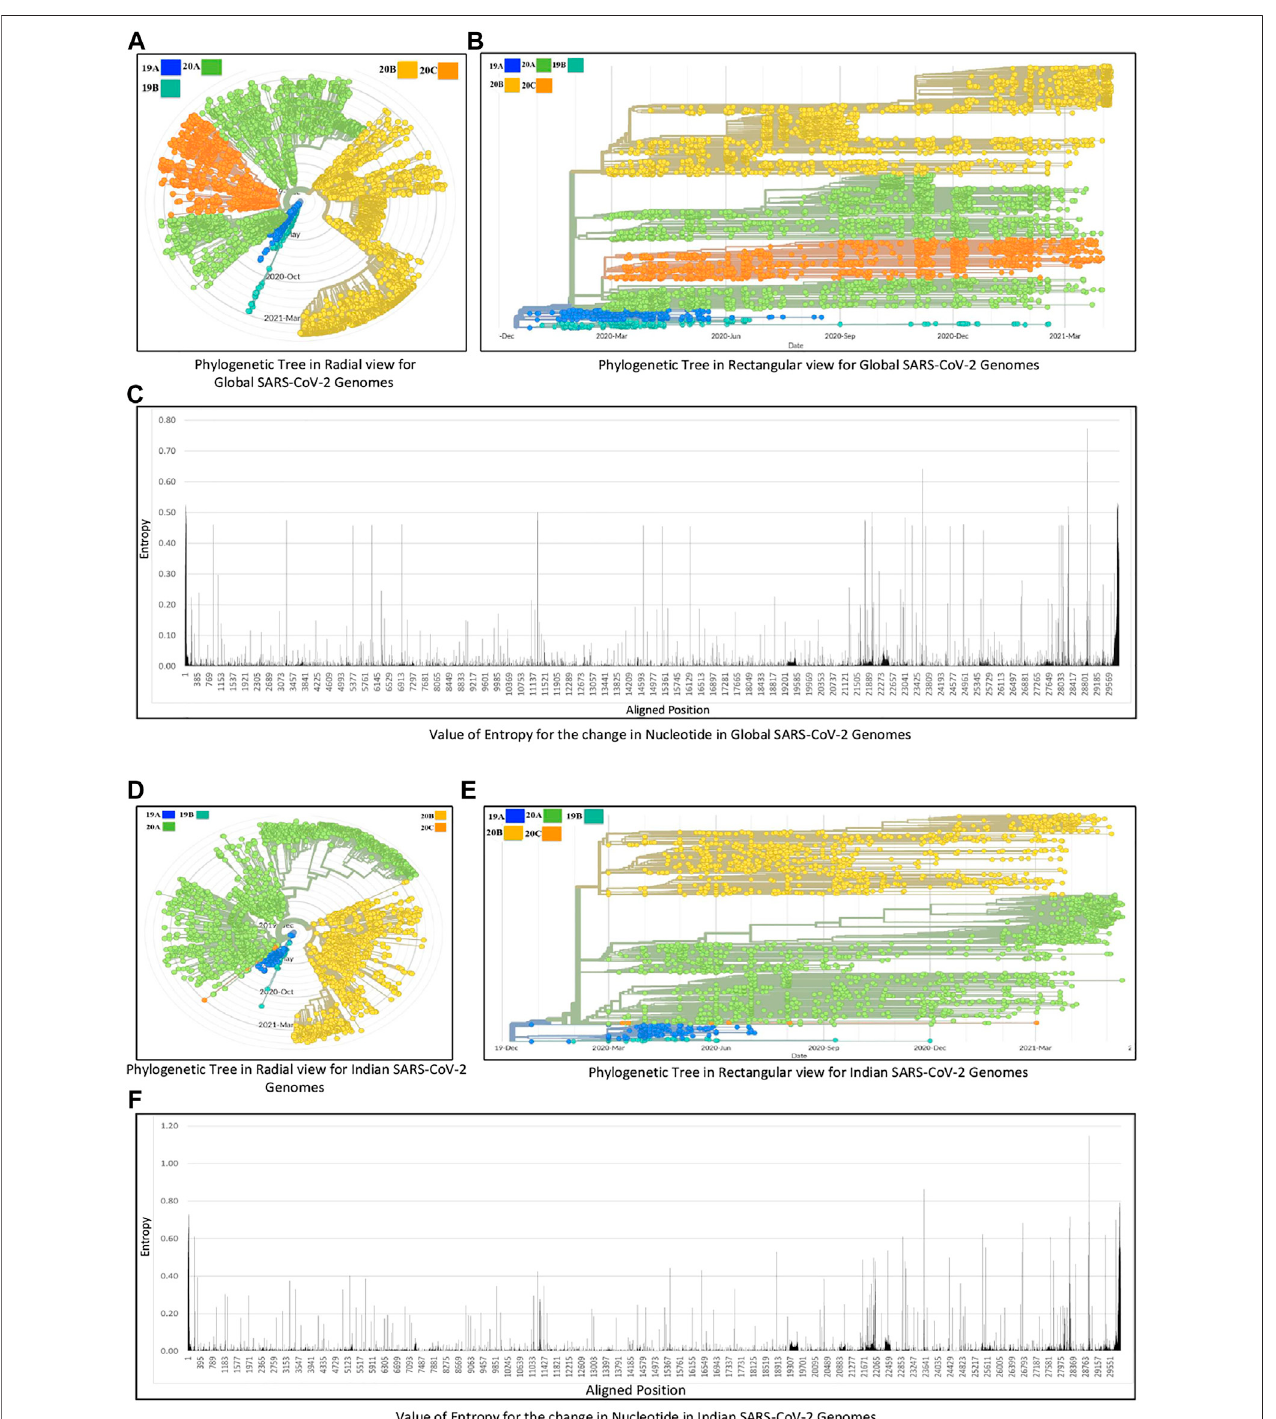
FIGURE 2 | Phylogenetic analysis of (A, B, C) global and (D, E, F) Indian SARS-CoV-2 genomes.